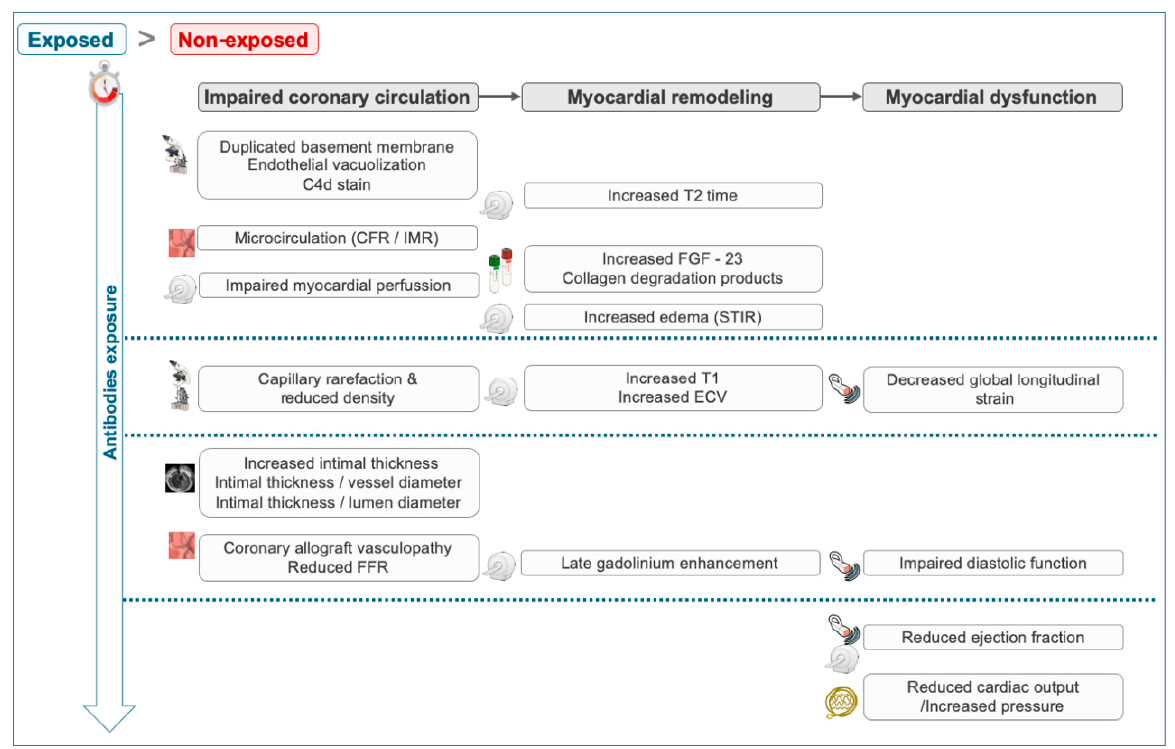
Figure 1. Working hypothesis and expected outcomes. CFR: coronary flow reserve; ECV: extracellular volume; FFR: fractional flow reserve; FGF: fibroblast growth factor; IMR: index of microvascular resistance; STIR: short tau inversion recovery.